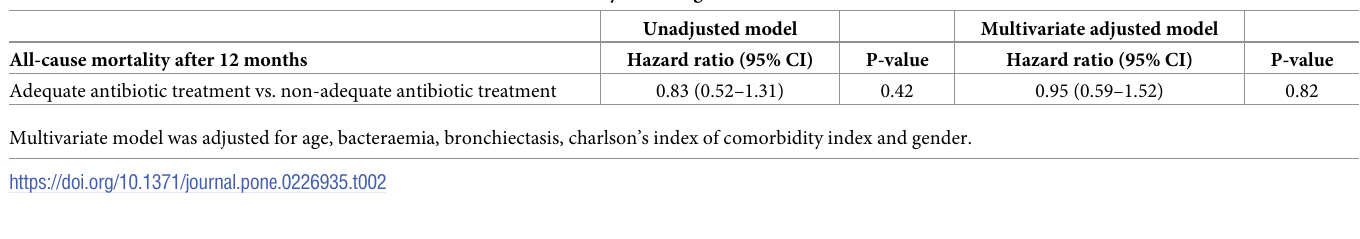
Table 2. Association between antibiotic treatment and all-cause mortality in cox regression